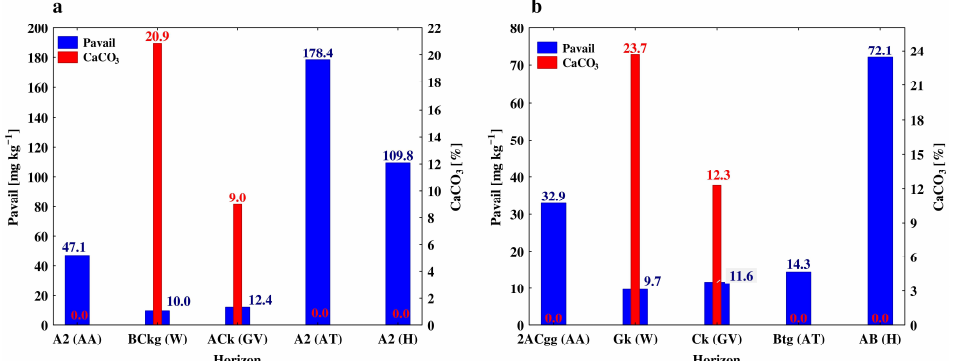
Figure 6. Effect of cultivated plants on the available phosphorus (Pavail) and CaCO 3 content in the sub-surface horizons ( a ) and third horizons ( b ) of the studied profiles. AA—alfalfa, W—winter wheat, GV—grapevine, AT—apple trees, H—hop. Values for each property marked with different letters are statistically different at p < 0.05. Abbreviations of soil horizon names are explained under Table